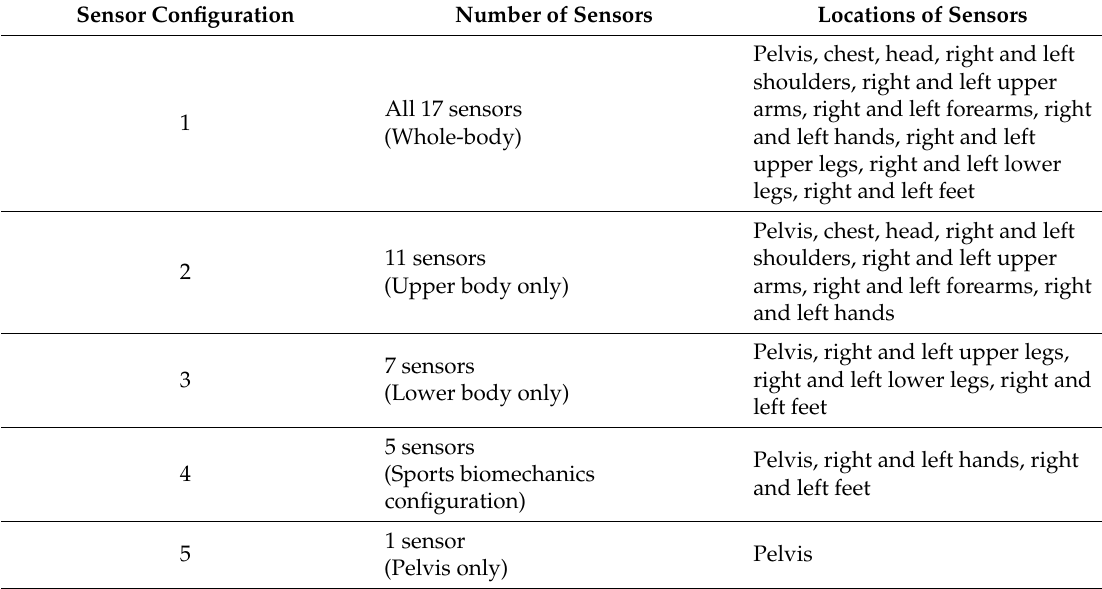
Table 7. Five combinations of the sensors for which the CNN-LSTM based deep learning model is trained.